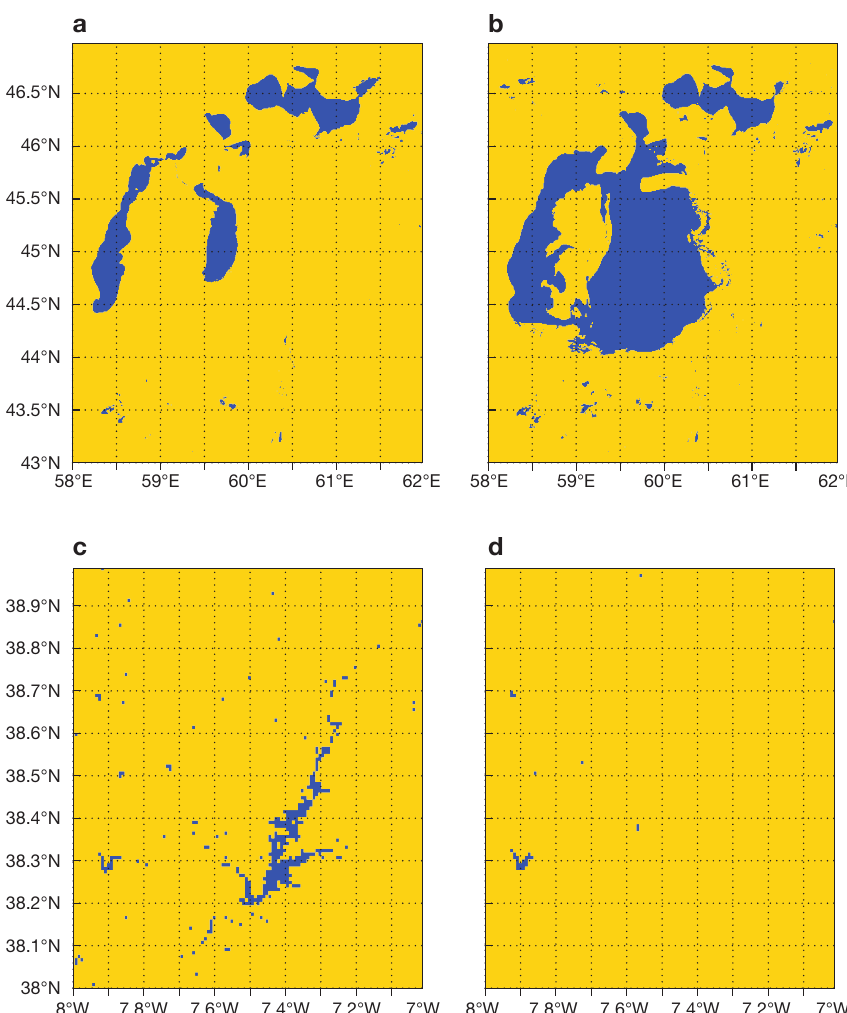
Figure 25. Aral sea (Kazakhstan/Uzbekistan, top panels, a and b ), and Alqueva reservoir (Portugal, lower panels, c and d ): water distribution in 2015 ( left, a and c ) and 1998 ( right, b and d ).